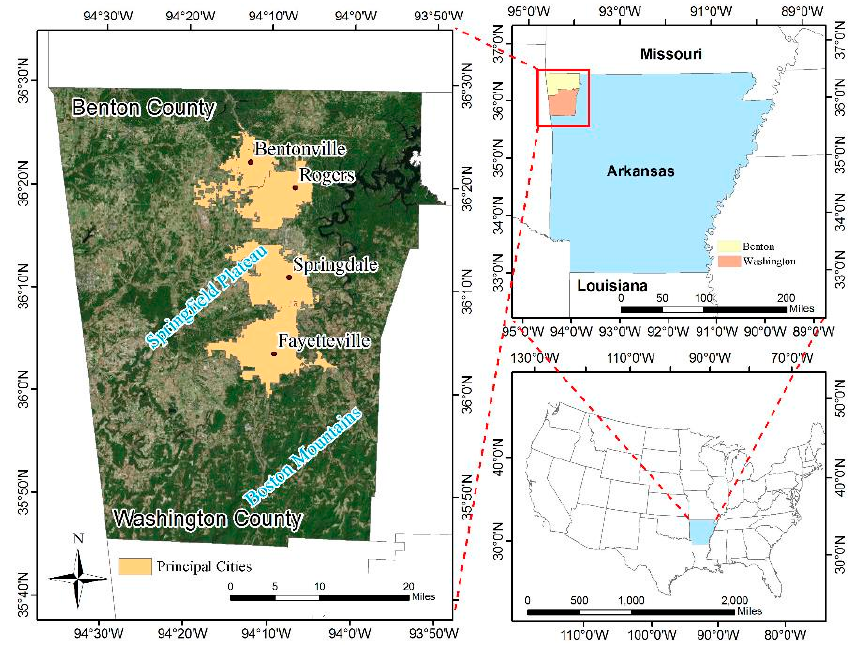
Figure 1. The Northwest Arkansas study area.